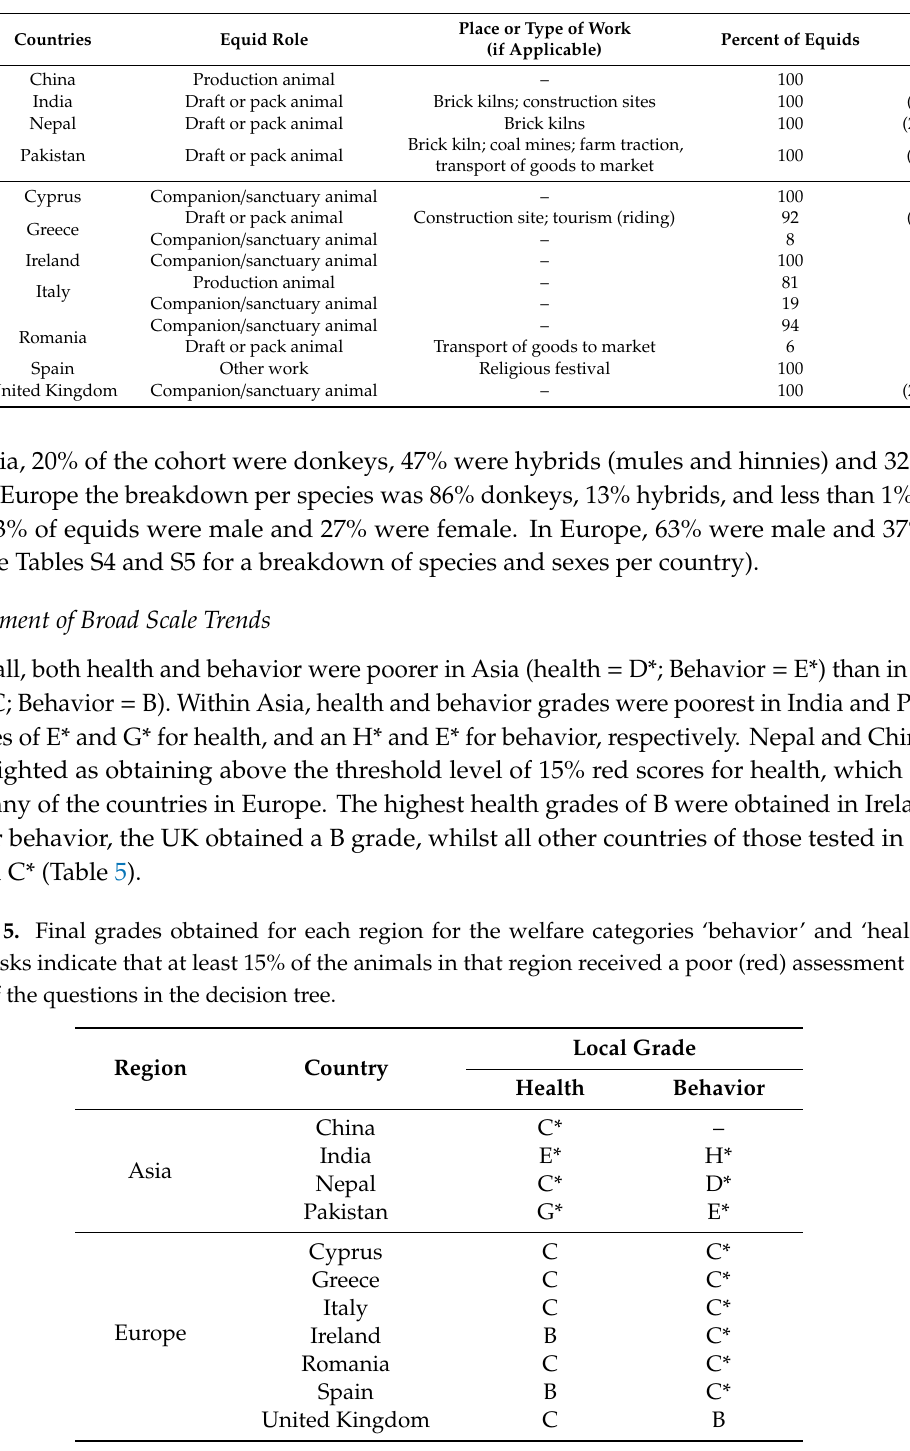
Table 4. Role of the equids assessed in each region and country. For working animals, the place or type of work is provided as a list. The percentage (Percent of equids) and number (n) of equids in each specified role per country is provided.